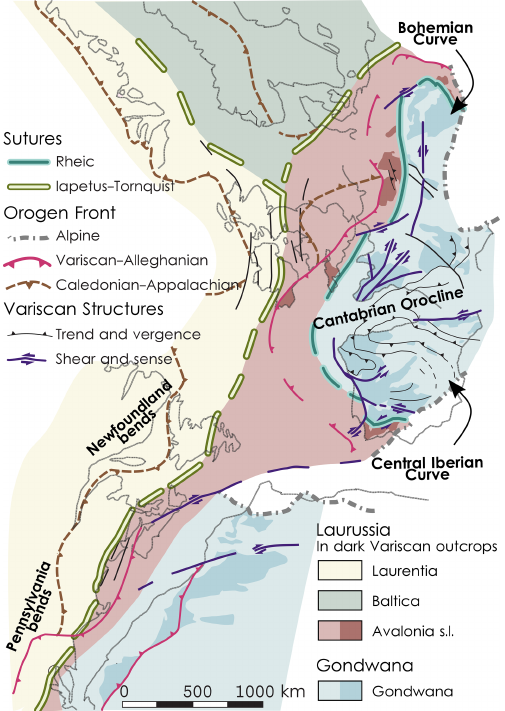
Figure 1. Simplified paleogeographic map of the Variscan– Alleghanian orogeny prior to the Jurassic breakup of Pangea, with the major orogenic curves labeled. Note, this map represents Iberian outcrops without taking into account post-Jurassic Alpine defor- mation (see text for details; e.g., Gong et al., 2008; Pastor-Galán et al., 2018). Slightly darker colors in the Variscan belt indi- cate present-day European and African outcrops (modified from Martínez Catalán et al., 2009; Weil et al.,